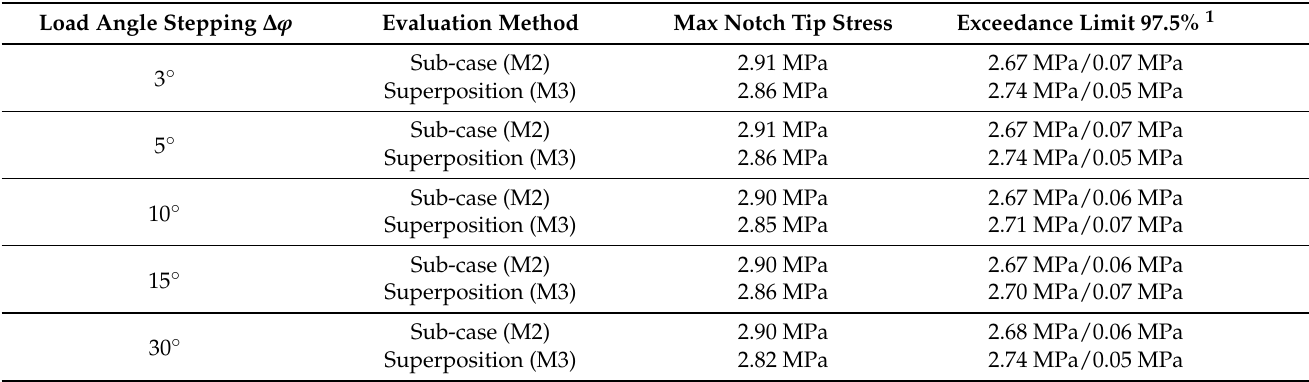
Table 5. Effect of load angle step on evaluated stress distribution of coarse-meshed circular hole-in- plate (refer to Figure 7a) for sub-case and superposition methods.